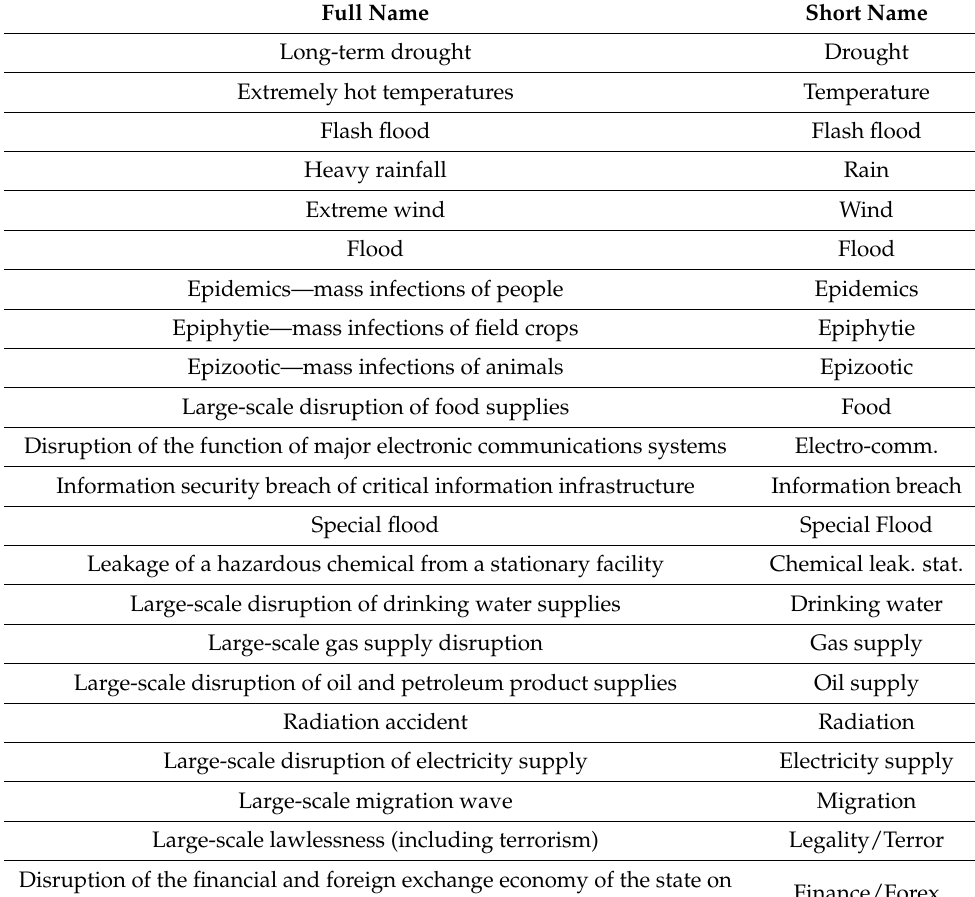
Table 1. Hazard types with unacceptable risk